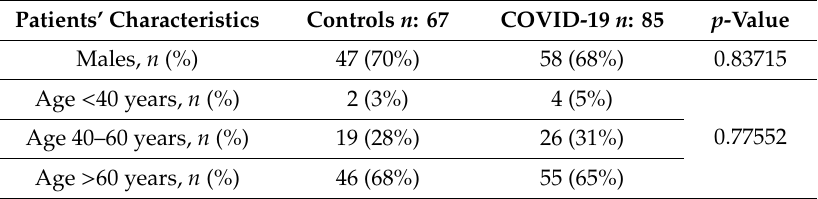
Table 1. Demographic characteristics of the study population.